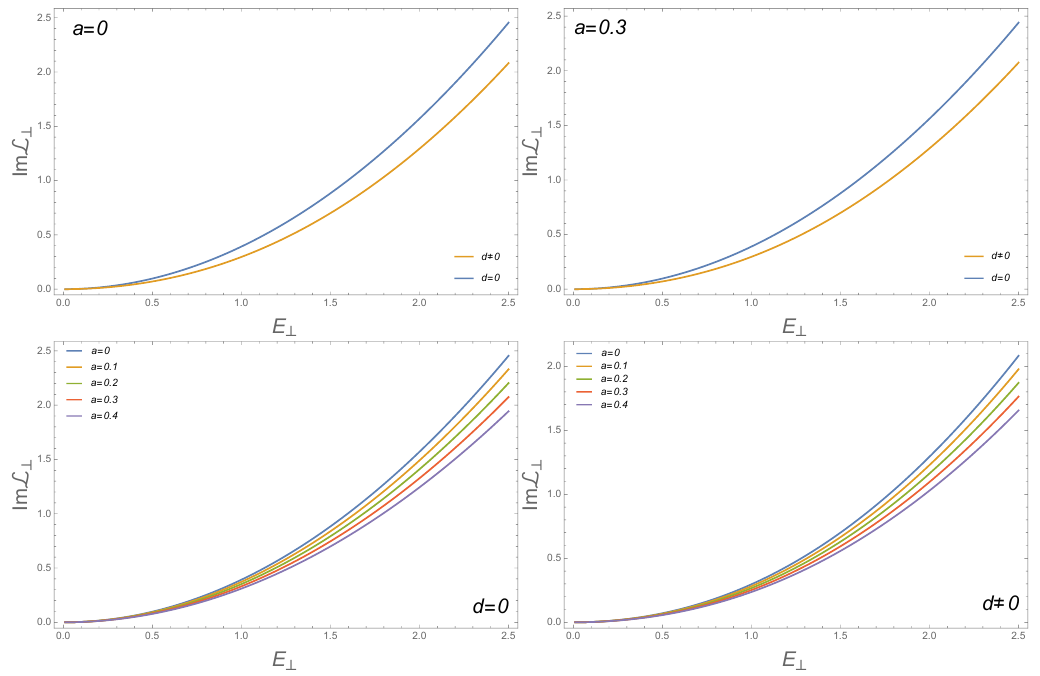
Figure 11 . The imaginary part of the Lagrangian L ⊥ in (5.13) as a function of E ⊥ with various a in the black brane